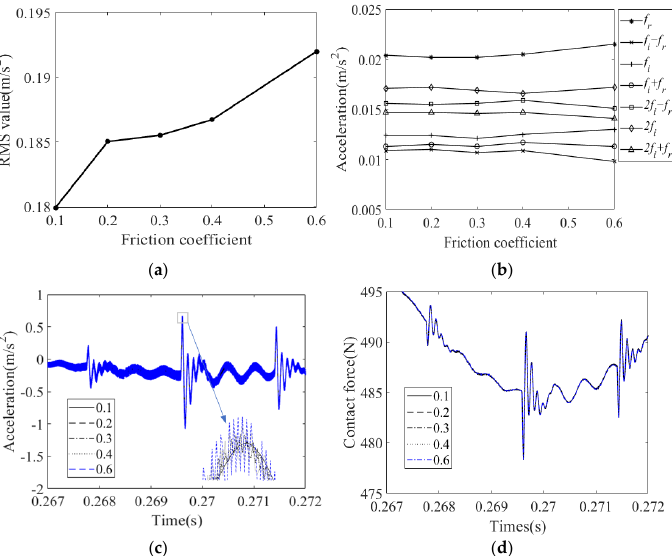
Figure 12. The vibration characteristics of the bearing under inner ring defect and friction coefficient: ( a ) RMS; ( b ) amplitudes of f r , f i − f r , f i , f i + f r , 2 f i − f r , 2 f i , 2 f i + f r ; ( c ) housing acceleration signal from 0.267 s to 0.272 s; ( d ) contact force between outer ring and housing from 0.267 s to 0.272 s.